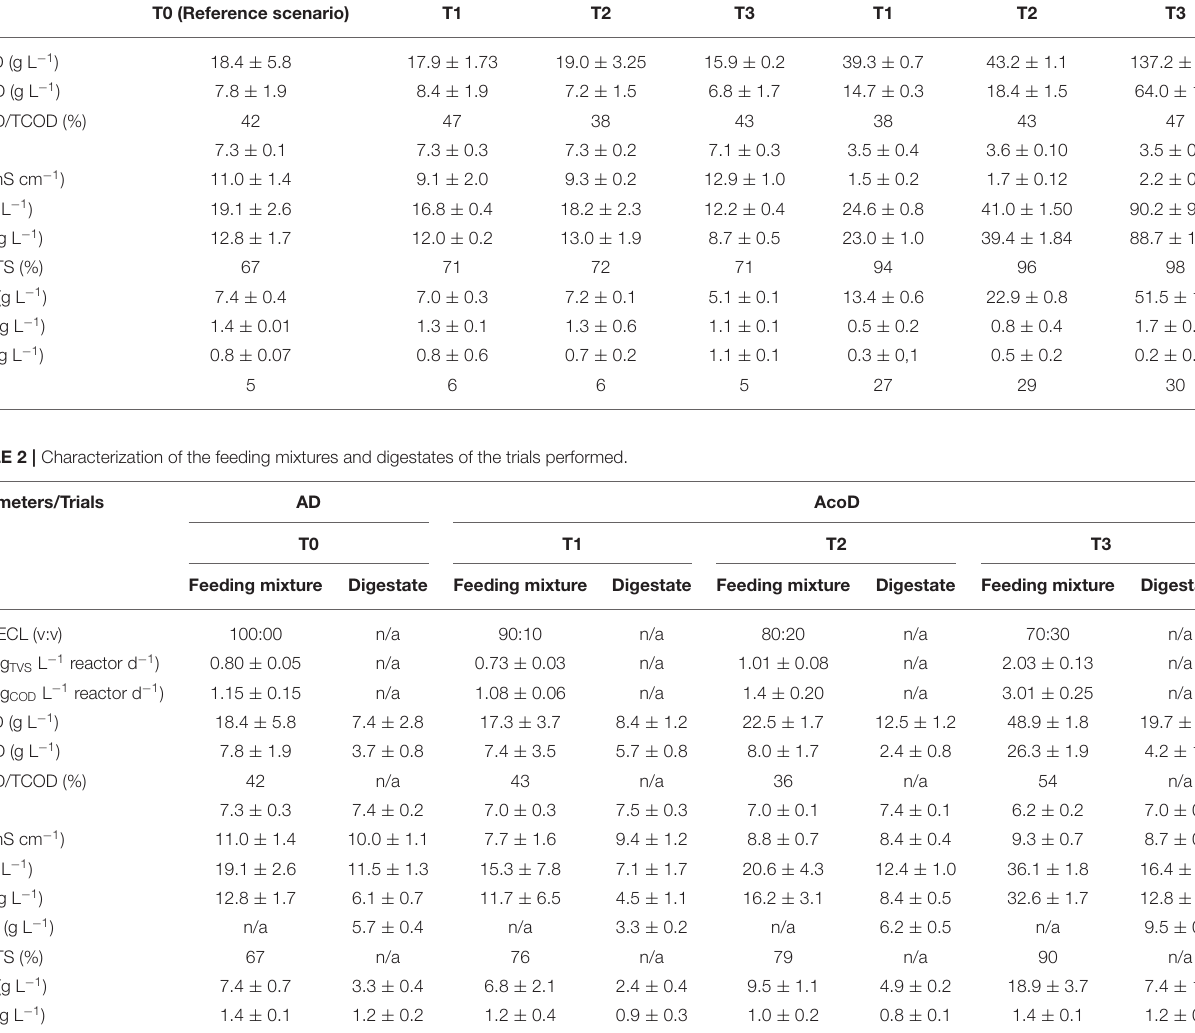
TABLE 1 | Physico-chemical characterization of substrates. Parameters/Trial